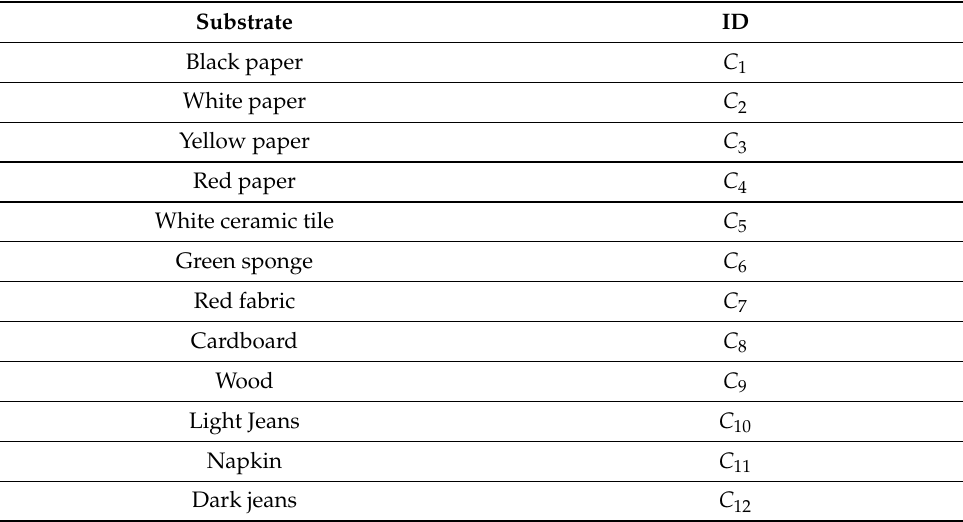
Figure 3. Blood stains samples on the 12 different substrates. Table 1. Substrate